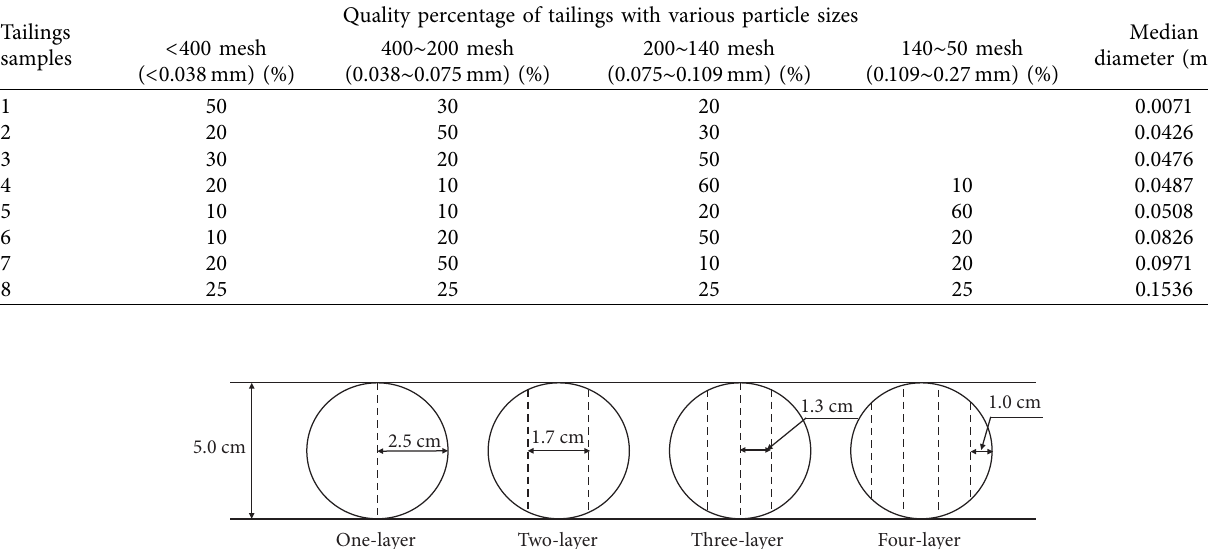
Table 1: Proportioning of tailings